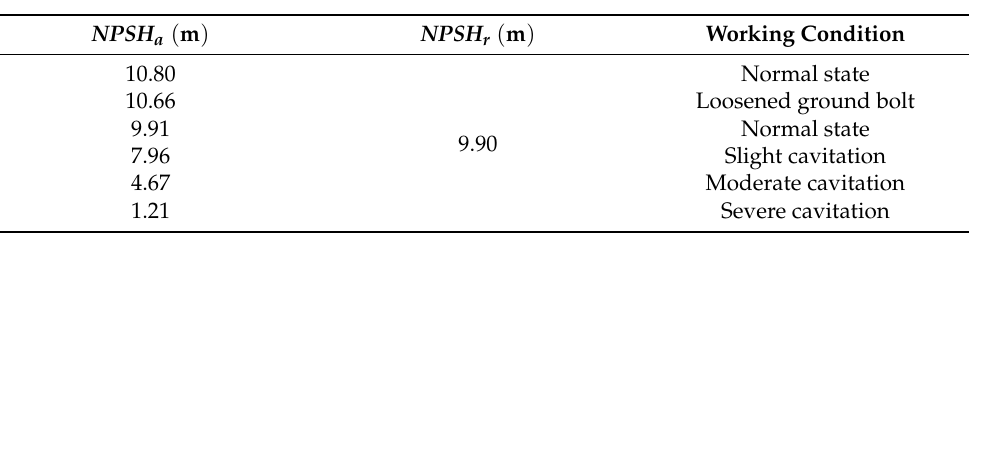
Table 1. The degree of cavitation of the pump under different valve